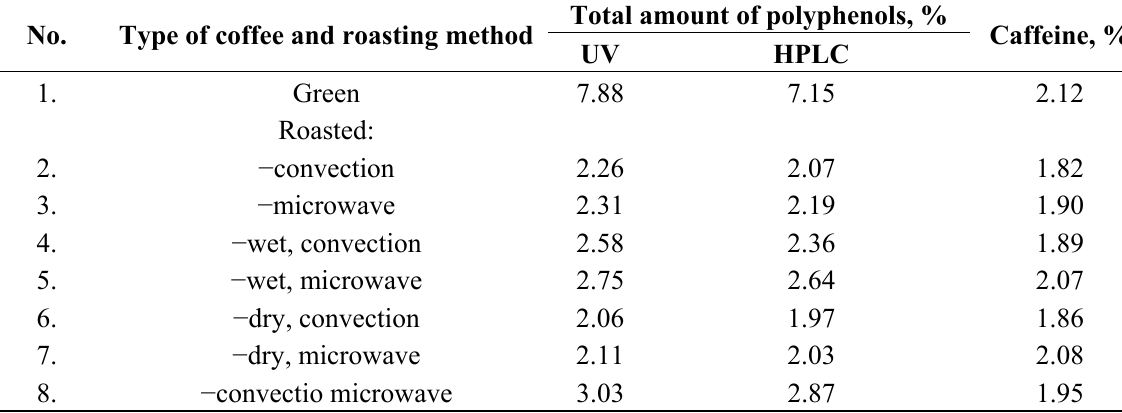
Table 6. Total polyphenols and caffeine content of raw and different roasted coffee beans [17]. No. Type of coffee and roasting